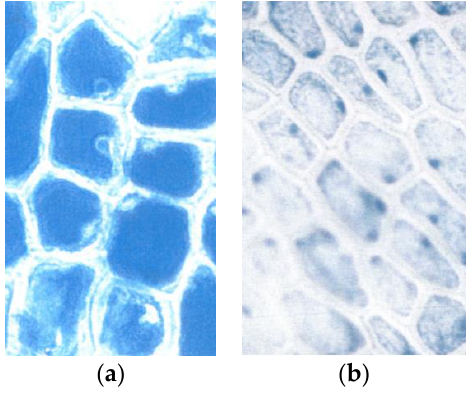
Figure 3. Longitudinal section of the upper epidermis ( a ) and lower epidermis ( b ), both DMACA treated. DMACA